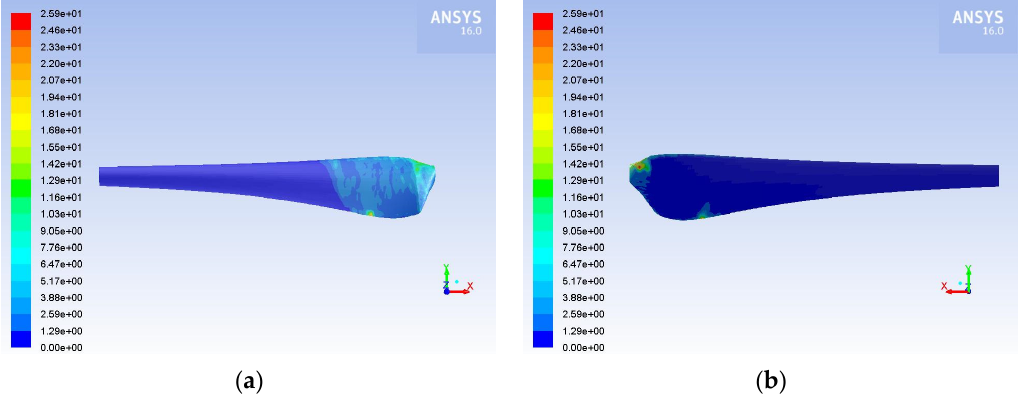
Figure 14. Concentration of particles on ( a ) the pressure; ( b ) the suction side of the blade for hailstorm conditions and air velocity equal to 15 m·s − 1 .